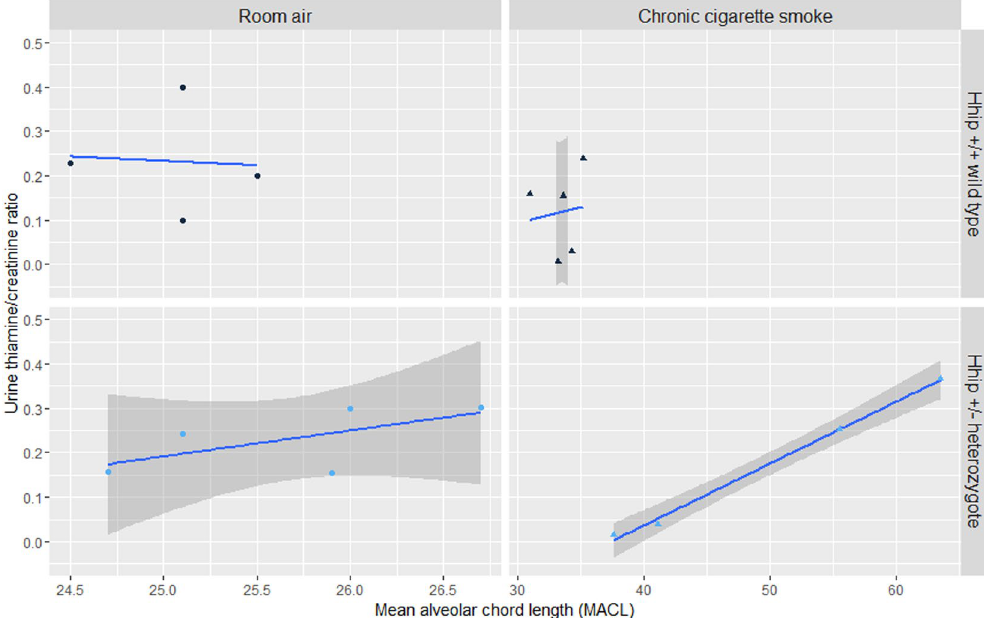
Figure 3. Association between urinary thiamine/creatinine ratio and lung mean alveolar chord length (MACL). A significant association between urinary thiamine/creatinine was noted in Hhip + / − heterozygotes exposed to chronic cigarette smoke (CS) (lower right panel, Pearson’s rho = 0.99, p-value = 1.67 × 10 –3 ). No association was observed in Hhip + / − mice exposed to room air or in Hhip + / + wild type mice in either experimental condition. The best fit line is plotted in blue while the 95% confidence interval is plotted in dark gray (except Hhip + / + , room air, where wide 95%CI exceeds panel borders).